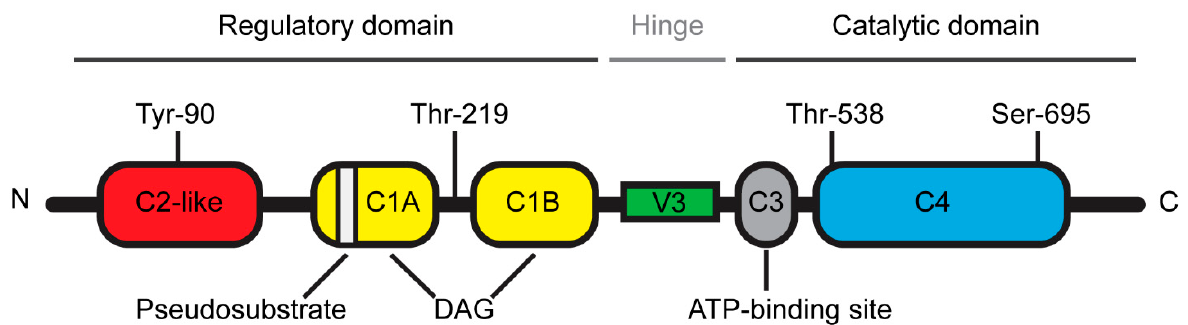
Figure 1. Schematic representation of Protein Kinase C theta (PKC θ ) structure.